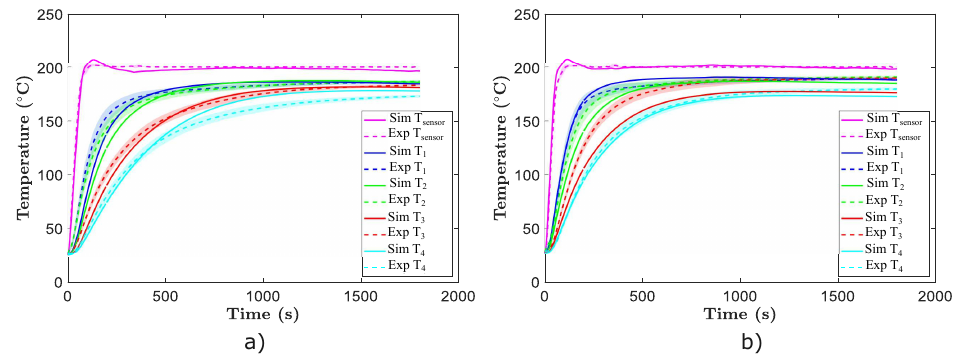
Figure 5. Temperatures of the surface and area under the glass from 0 to 1800 s for both the experimen- tal test (dotted lines) and computational simulations (continuous lines) in Model I. ( a ) corresponds to the WMF pan and ( b ) to the Schulte